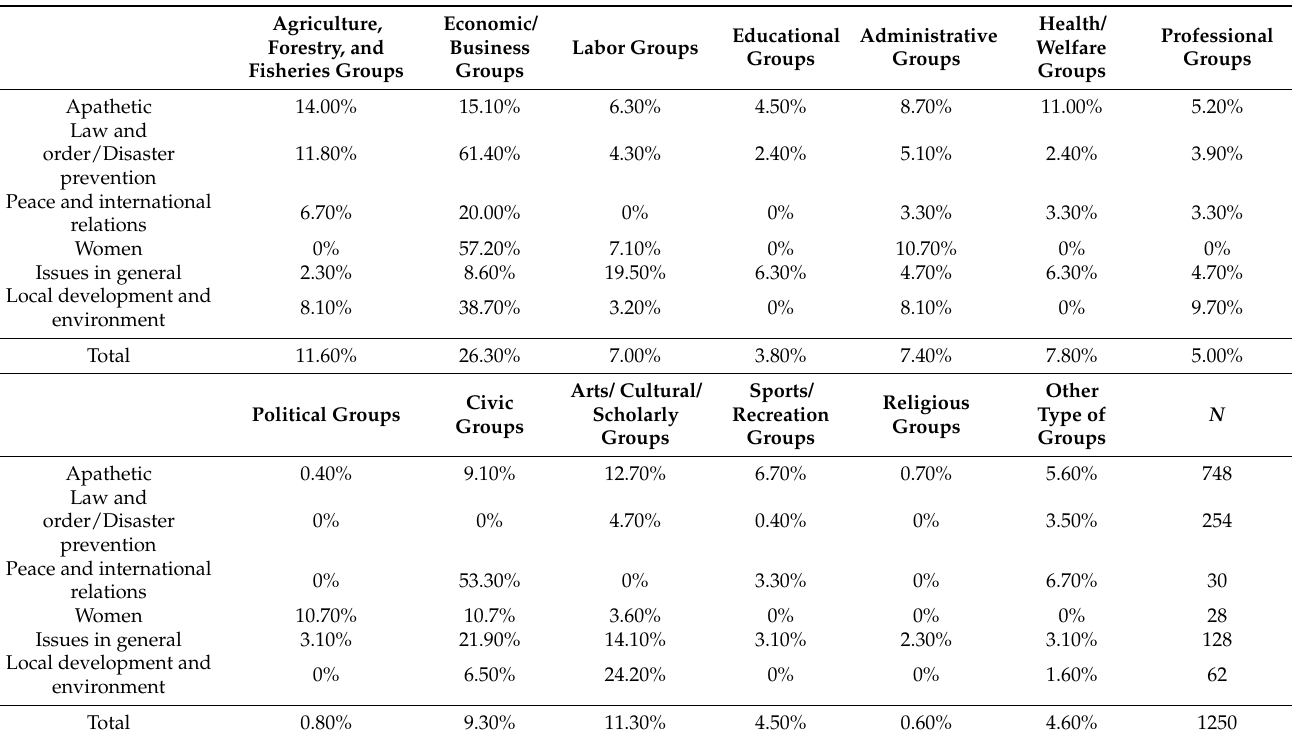
Table 6. Organization